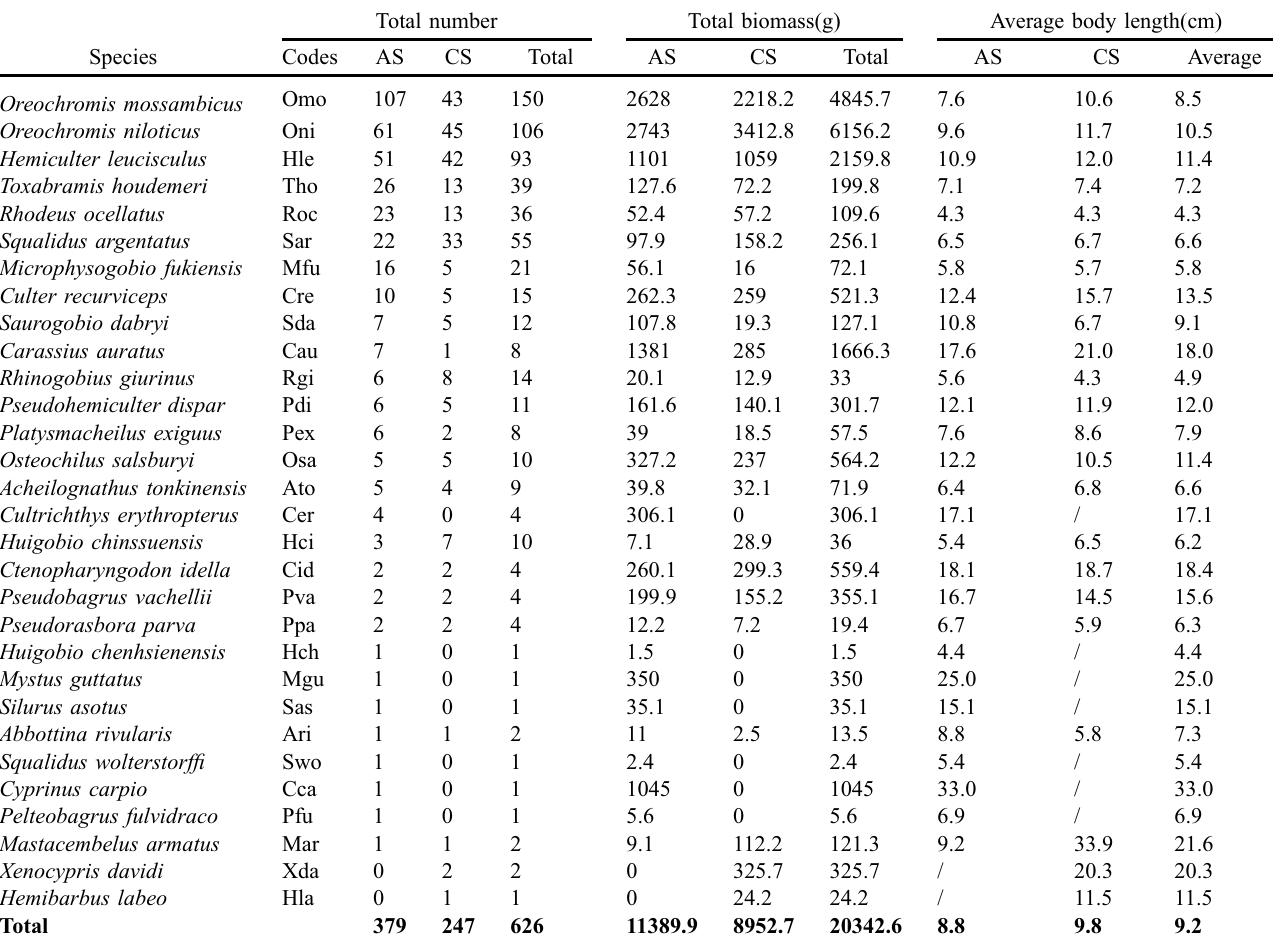
Table 2. Total number of individuals, biomass (g), and average body length (cm) of species caught at the arti fi cial structures (AS) and control